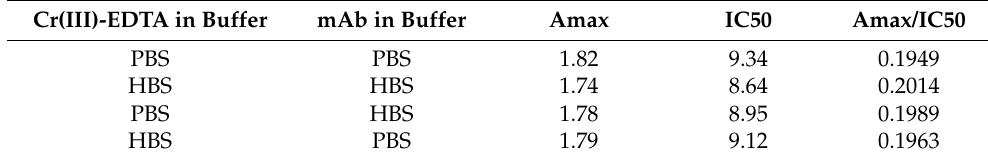
Table 2. IC50 and Amax/IC50 values of Cr(III)-EDTA and 2B6 mAb in different assay buffers. Cr(III)-EDTA in